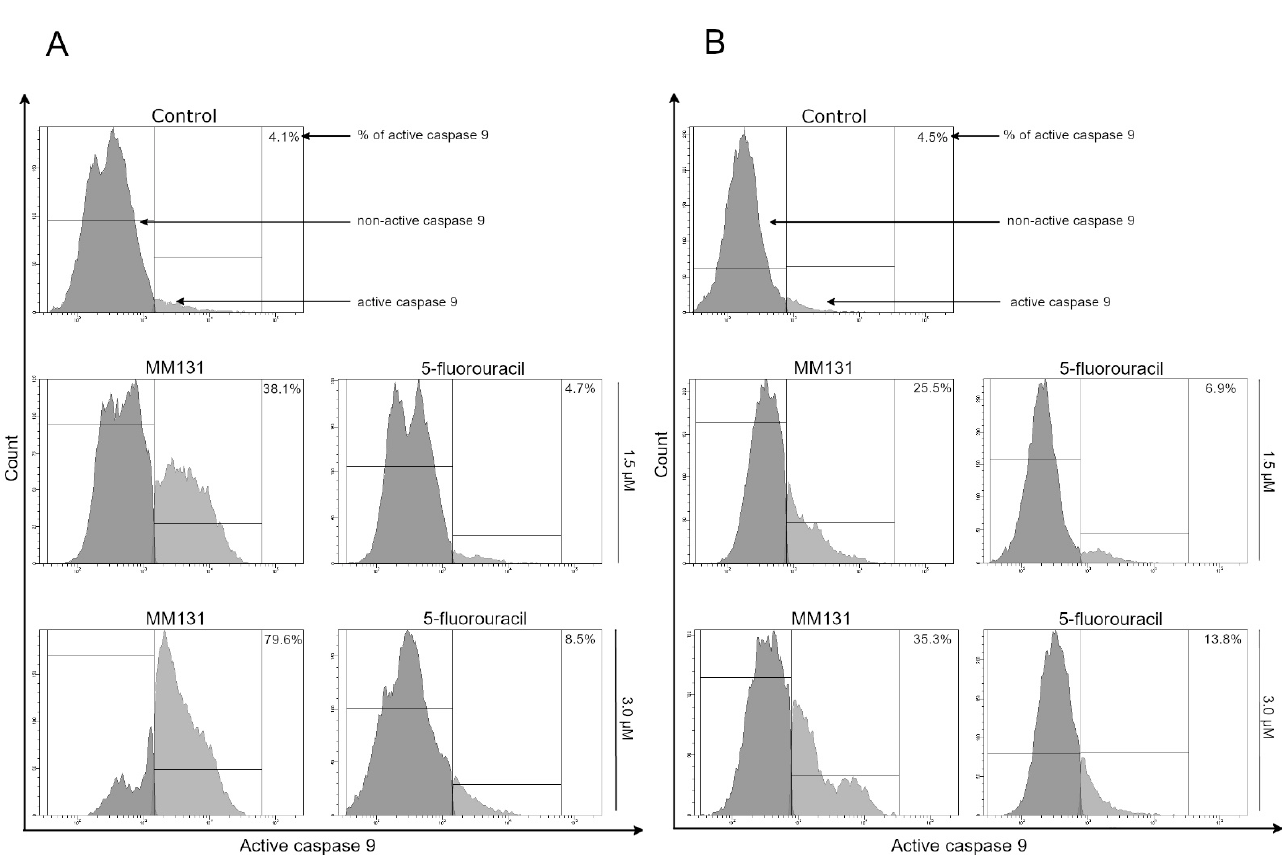
Figure 5. Flow cytometric analysis of caspase-9 activity in DLD-1 ( A ) and HT-29 ( B ) colorectal cancer cells after 24 h incubation with MM131 and 5-fluorouracil. The number of cells with active caspase-9 is represented as a mean of three separate experiments.